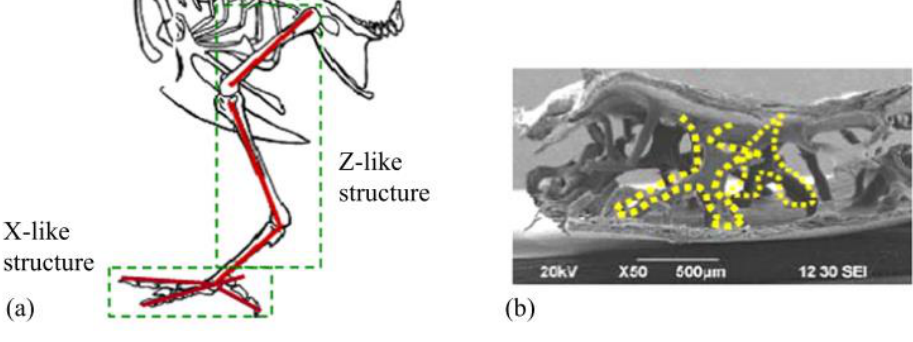
Figure 8. ( a ) A bird skeleton and ( b ) cranial bone